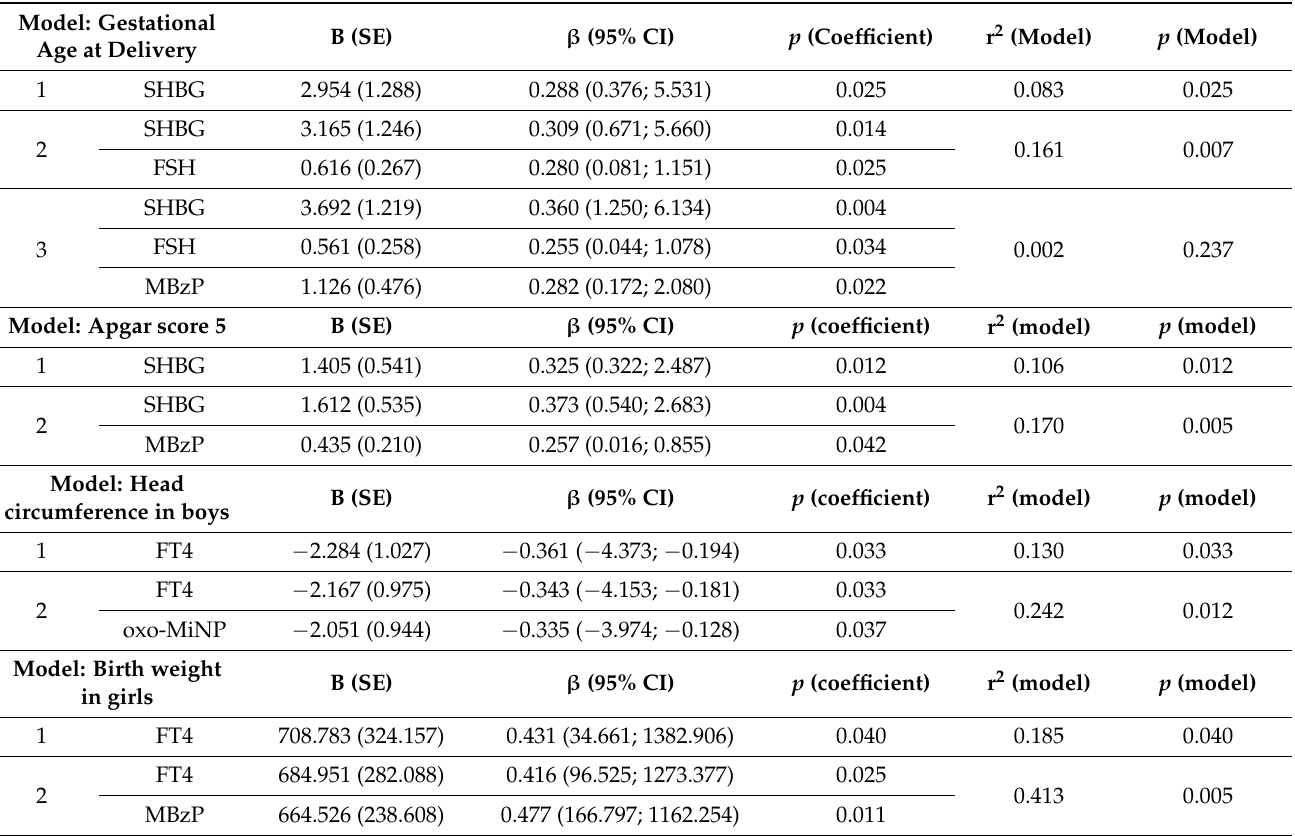
Table 8. Relationship between neonatal parameters and maternal endocrine parameters (early pregnancy) in the context of phthalate exposure.